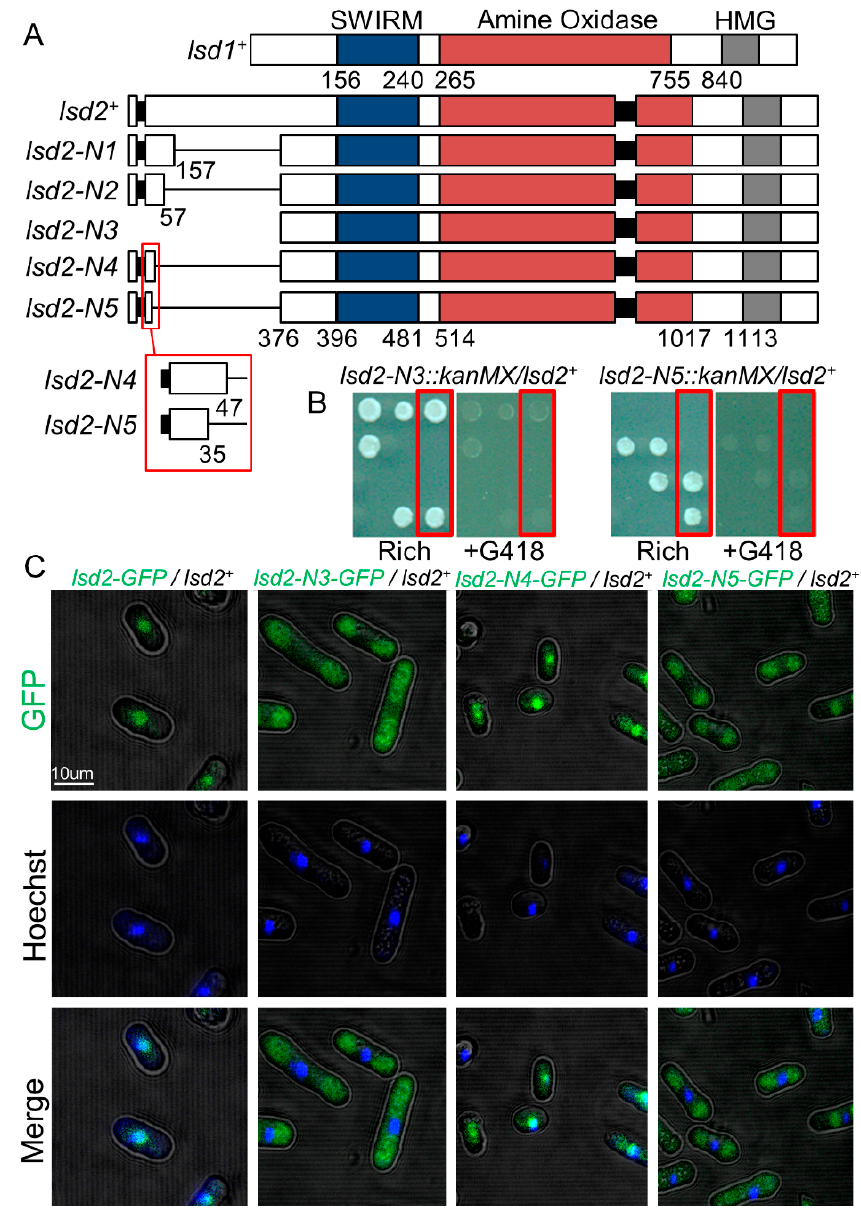
Figure 1 . Nuclear localization of Lsd2 is required for viability . ( A ) Schematic representation of N-terminal mutants of Lsd2. Numbers indicate the position in the amino acid sequence of Lsd2 and Lsd1. ( B ) Lsd2 N-terminal mutants lsd2-N3 and lsd2-N5 are inviable. Heterozygous diploids containing one copy of the mutant allele (linked with resistance to the antibiotic G418) and one copy of the wild-type (WT) allele were sporulated and tetrads of spores were arranged in columns. Red box: sample of a tetrad that shows selective growth on rich media with or without G418. ( C ) Visualization of GFP-tagged full-length or N-terminal truncated Lsd2 proteins in viable heterozygous diploid strains by confocal fluorescence microscopy. Indicated strains were also stained with Hoechst to show nuclear localization.